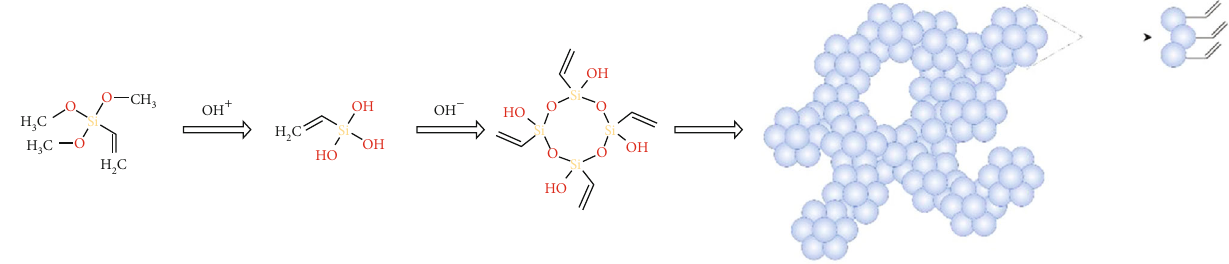
Figure 1: Preparation of vinyl modi fi ed silica aerogel